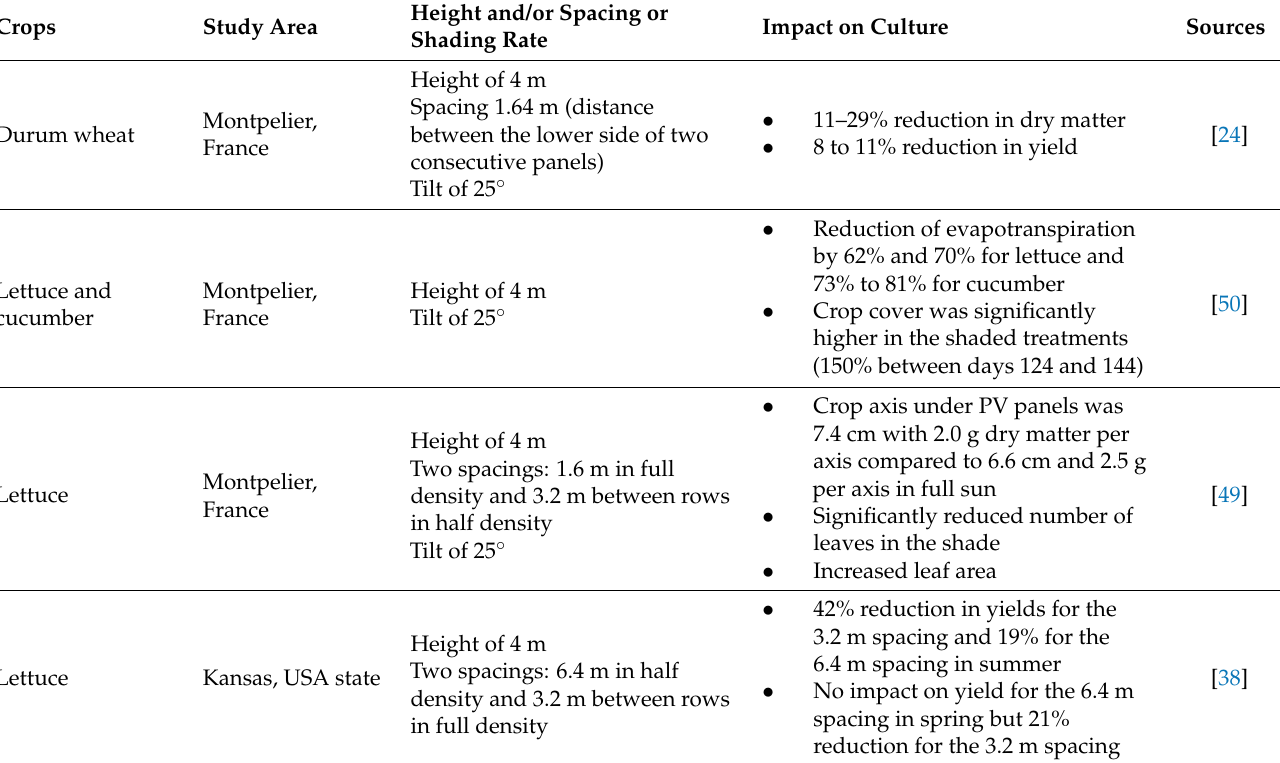
Table 2. Impact of photovoltaic panels on different crops in different